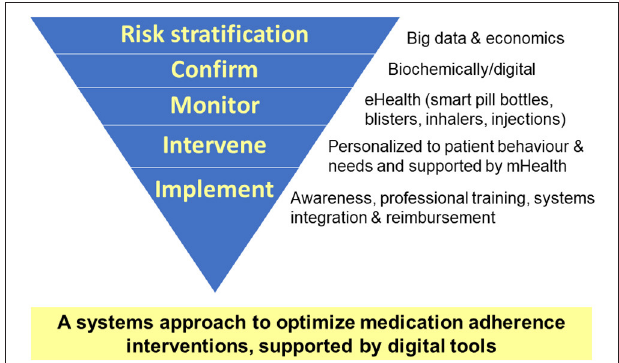
FIGURE 1 | A systems approach to increase the effectiveness of medication adherence